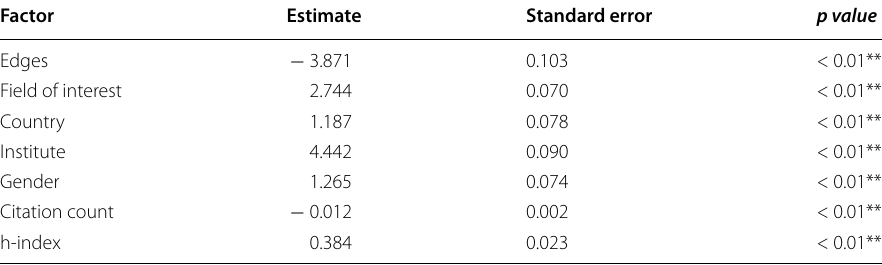
Table 4 Coefficients for ERGM of the MACN Factor